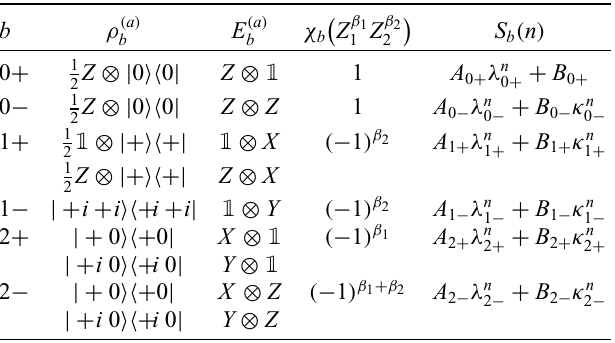
TABLE II. The initial states, measurements, weighting, and fit- ting functions for interleaved-bias RB. In the fitting functions, λ b and κ b are two independent RB decay parameters. | ± i (cid:8) denotes eigenstates of the Y